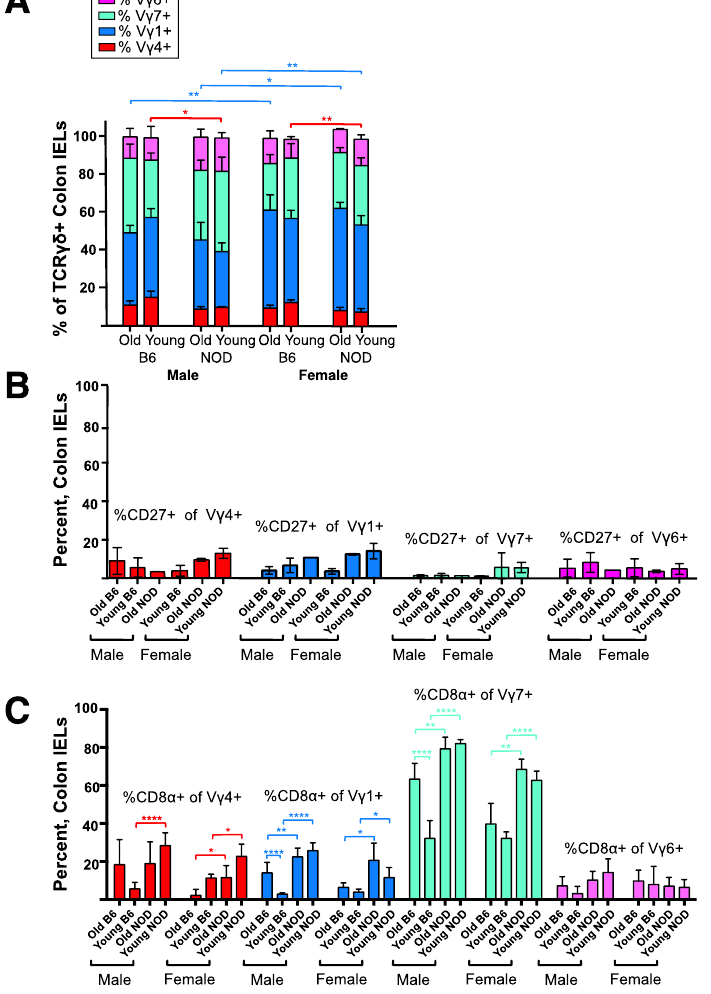
Figure 4. Comparison of colon intraepithelial lymphocyte (IEL) derived T cells in NOD vs. B6 mice. Results for samples from 3-7 mice per group analyzed by flow cytometry, except for C in which only 2 old B6 males, 2 old NOD females, and 1 old NOD male were available for the analysis (errors bars for old B6 male and old NOD female groups show the range obtained rather than the sample standard deviation). ( A ) . The mean percentage of each of four V γ -defined γδ T cell subsets as a fraction of all γδ TCR+ cells, among the IELs obtained from individual colons. ( B ) . Within each group, the mean percentage of CD27+ cells was relatively low for colon IELs of the V γ 1, V γ 4, V γ 7, and V γ 6 subsets. Scale matches that used in C. ( C ) . Within each group, the mean percentage of CD8 α + cells for colon IELs of the V γ 1, V γ 4, V γ 7, and V γ 6 subsets was generally higher in NOD mice than in matched B6 controls. * p < 0.05, ** p < 0.01, and **** p < 0.0001.